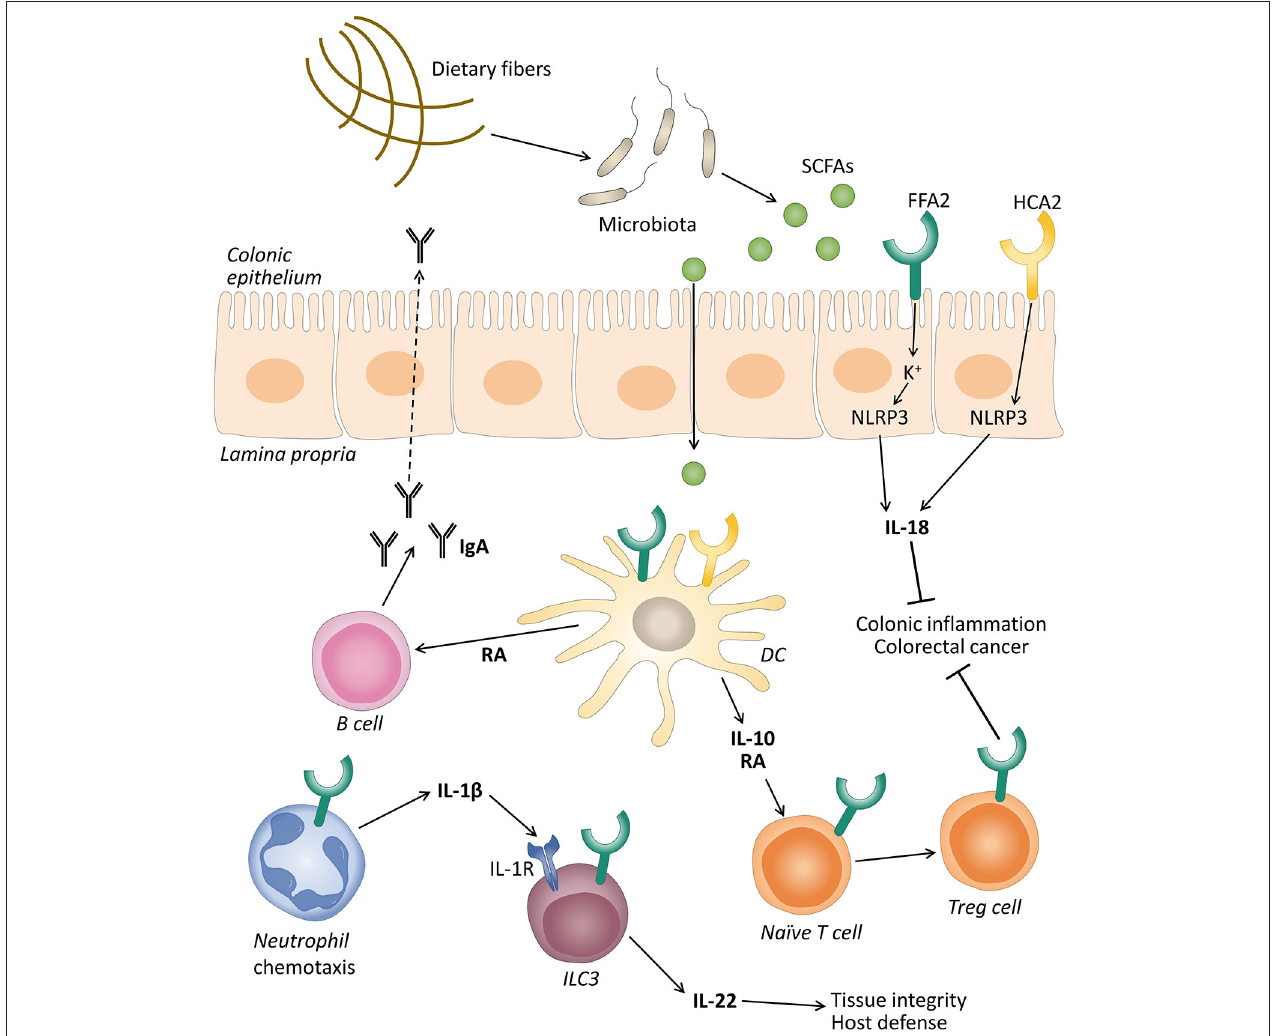
FIGURE 1 | The role of free fatty acid receptor 2 (FFAR2) and hydroxycarboxylic acid receptor 2 (HCAR2) in gut homeostasis. Gut microbiota ferment dietary fibers into short-chain fatty acids (SCFAs), and these can activate their receptors expressed on intestinal epithelial cells and immune cells like neutrophils, dendritic cells (DC), and innate lymphoid cells 3 (ILC3). The activation of FFAR2 and HCAR2 in intestinal epithelial and DC promotes the secretion of interleukin (IL)-18 via inflammasome activation, and IL-10, respectively. IL-10 in turn promotes the differentiation and proliferation of T regulatory (Treg) cells that together with IL-18 protect against conditions leading to colonic inflammation and colorectal cancer. SCFAs through FFAR2 induce neutrophil chemotaxis to inflammatory sites and production of IL-1 β . IL-1 β engages an IL-1 receptor (IL-1R) on ILC3, promoting IL-22 production that will contribute to tissue integrity and host defense. SCFAs can also stimulate the intestinal immunoglobulin A (IgA) secretion by B cells, induced by retinoic acid (RA) production, although this mechanism is still